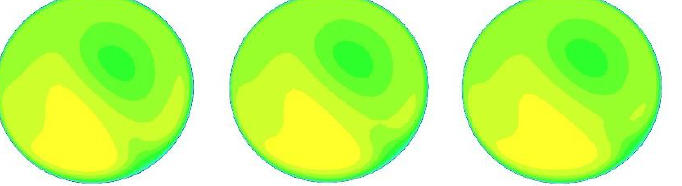
Sensors 2022 , 22 , x